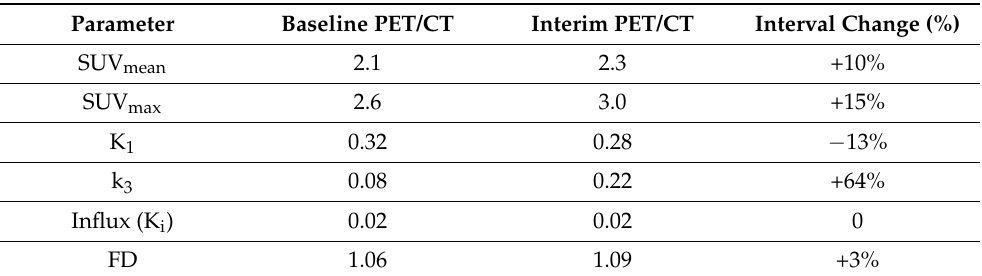
Table 4. Median values of the 18 F-FDG semiquantitative and quantitative parameters, derived from the thyroid, before and after two cycles of anti-PD-1 therapy as well as their interval changes (%) as a response to treatment. The units of parameters K 1 , k 3 and influx are 1/min. SUV mean , SUV max and FD have no unit.